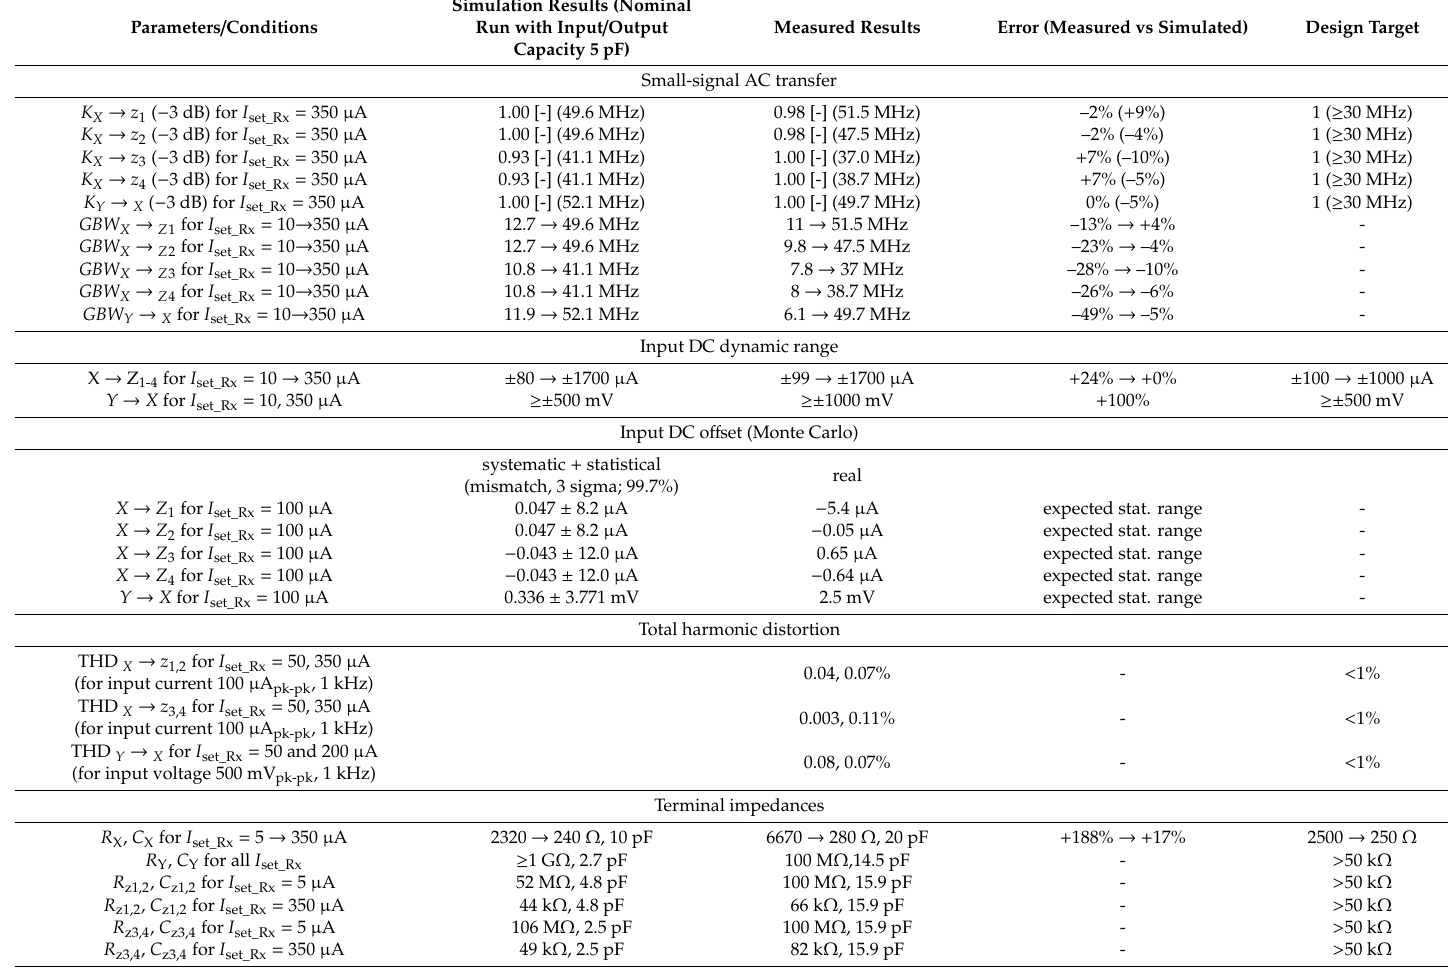
Table A4. Summary of the simulated and measured performances of the CCCII